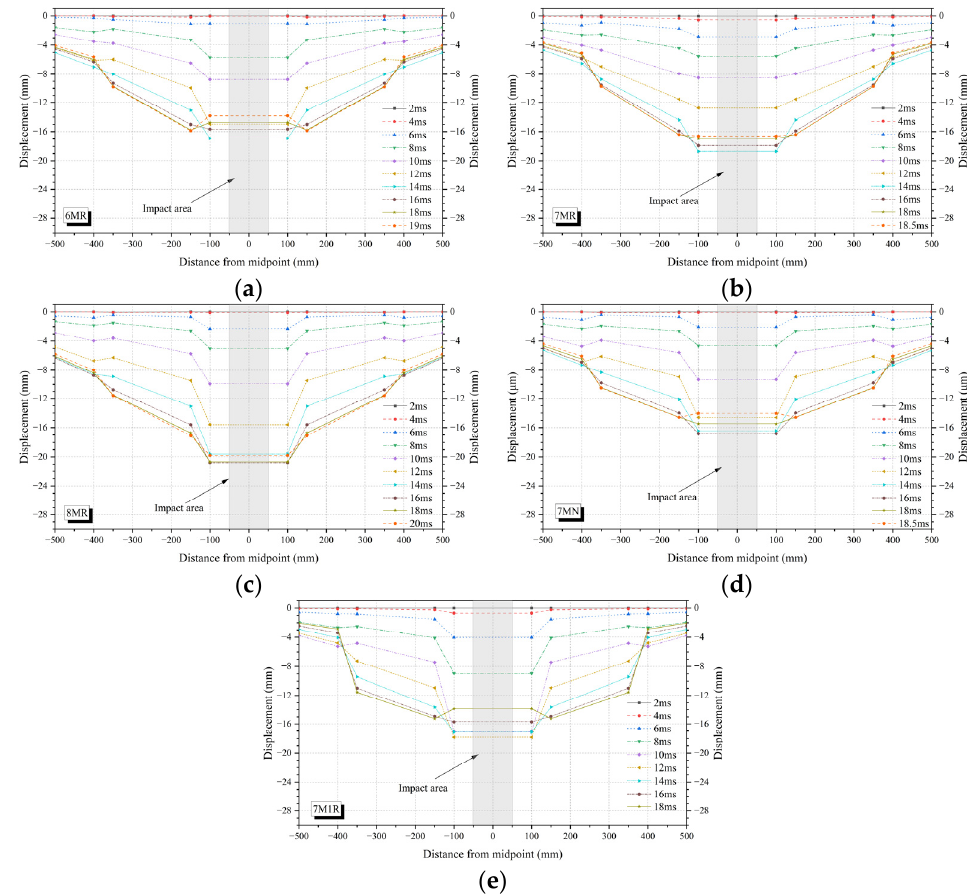
Figure 12. Deflected shapes of the ( a ) 6MR specimen, ( b ) 7MR specimen, ( c ) 8MR specimen, ( d ) 7MN specimen, and (e) 7M1R specimen.